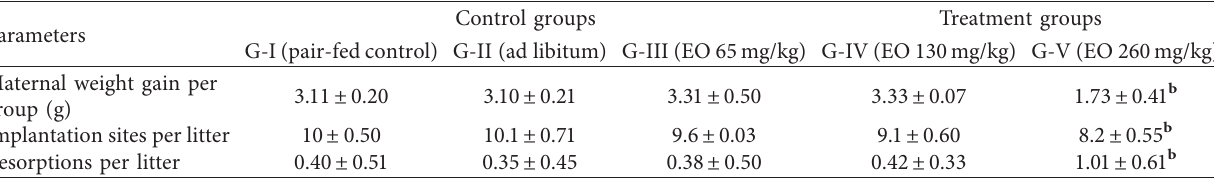
Table 1: Pregnancy outcome following treatment of pregnant rats with the essential oil of Thymus schimperi : day 12 experiment.